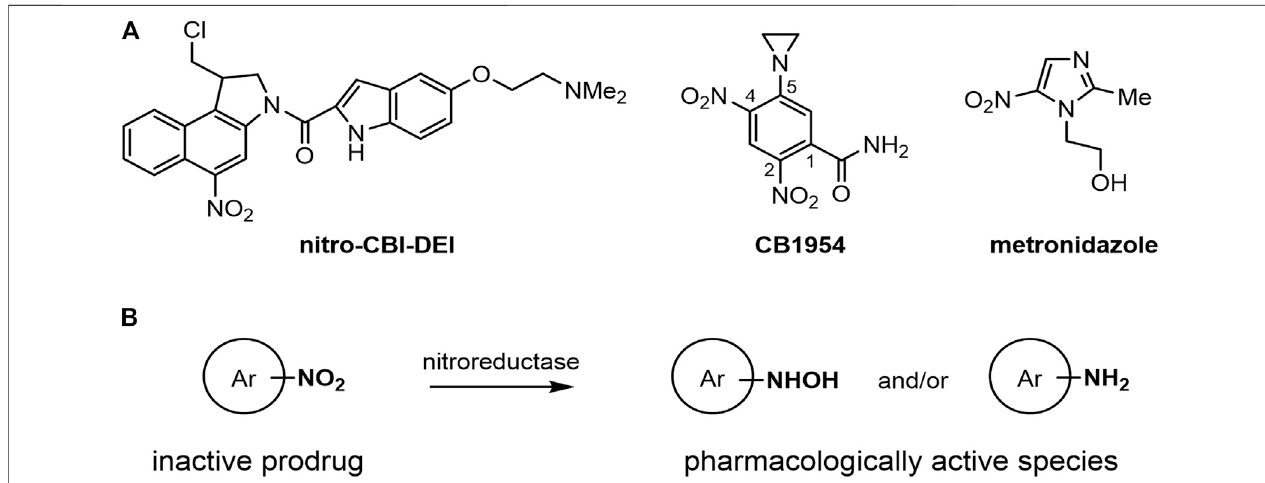
FIGURE 1 | Structures and generic reaction scheme for the nitroaromatic prodrugs central to this work. (A) Structures of nitro-CBI-DEI, CB1954 and metronidazole. (B) Generic scheme showing nitroreductase-mediated activation of nitroaromatic prodrugs. The reduction of the strongly electron-withdrawing nitro group to electron-rich hydroxylamine or amine products can be used as a trigger to convert an inactive compound to products capable of alkylating DNA or proteins.